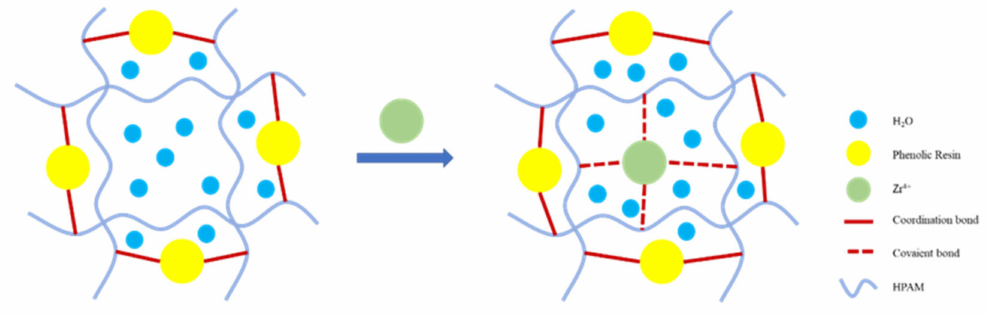
Figure 8. Schematic diagram of the secondary cross-linking reactions.